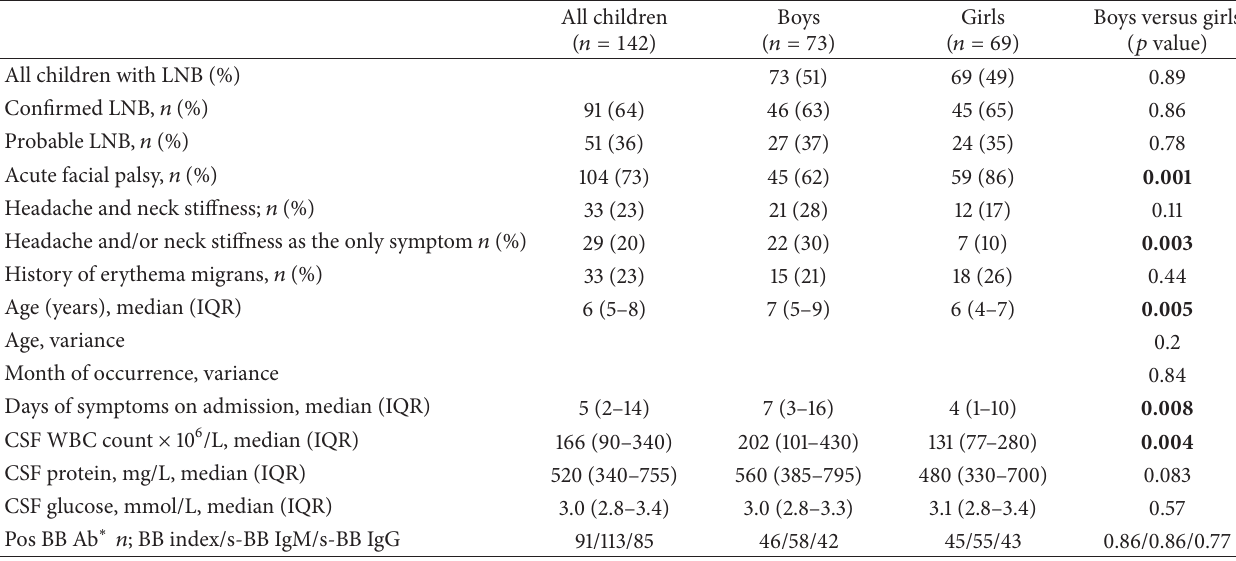
Table 2: Differences in numbers and clinical and laboratorial characteristics between boys and girls in 142 children hospitalized with Lyme neuroborreliosis (LNB) at Stavanger University Hospital during